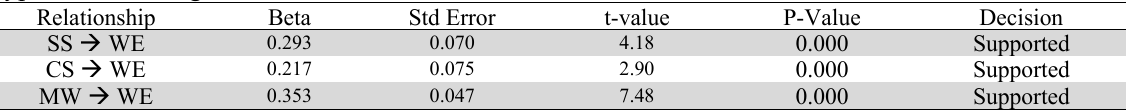
Fig. 2. Structural Model- Direct Results Hypothesis Testing- Direct Results